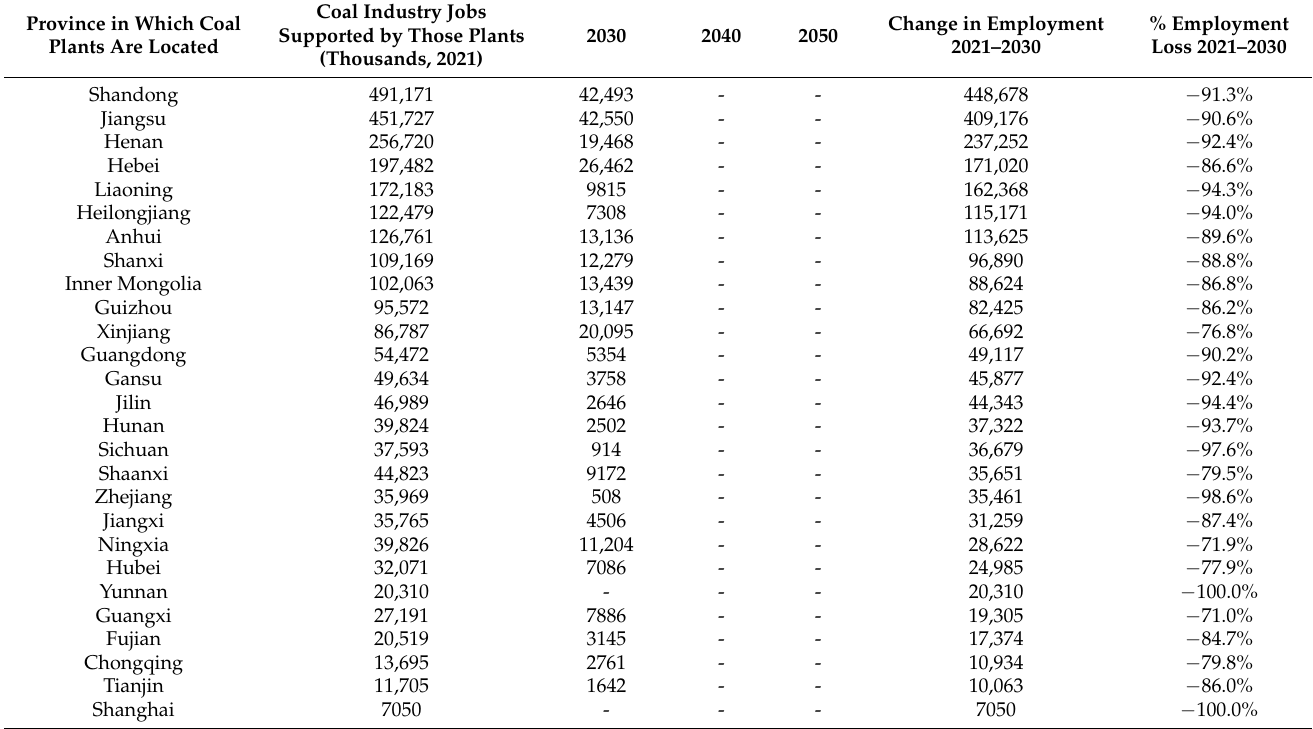
Table A6. Trends in coal industry employment supported by each province, 2021–2060 and change to 2030 (C80